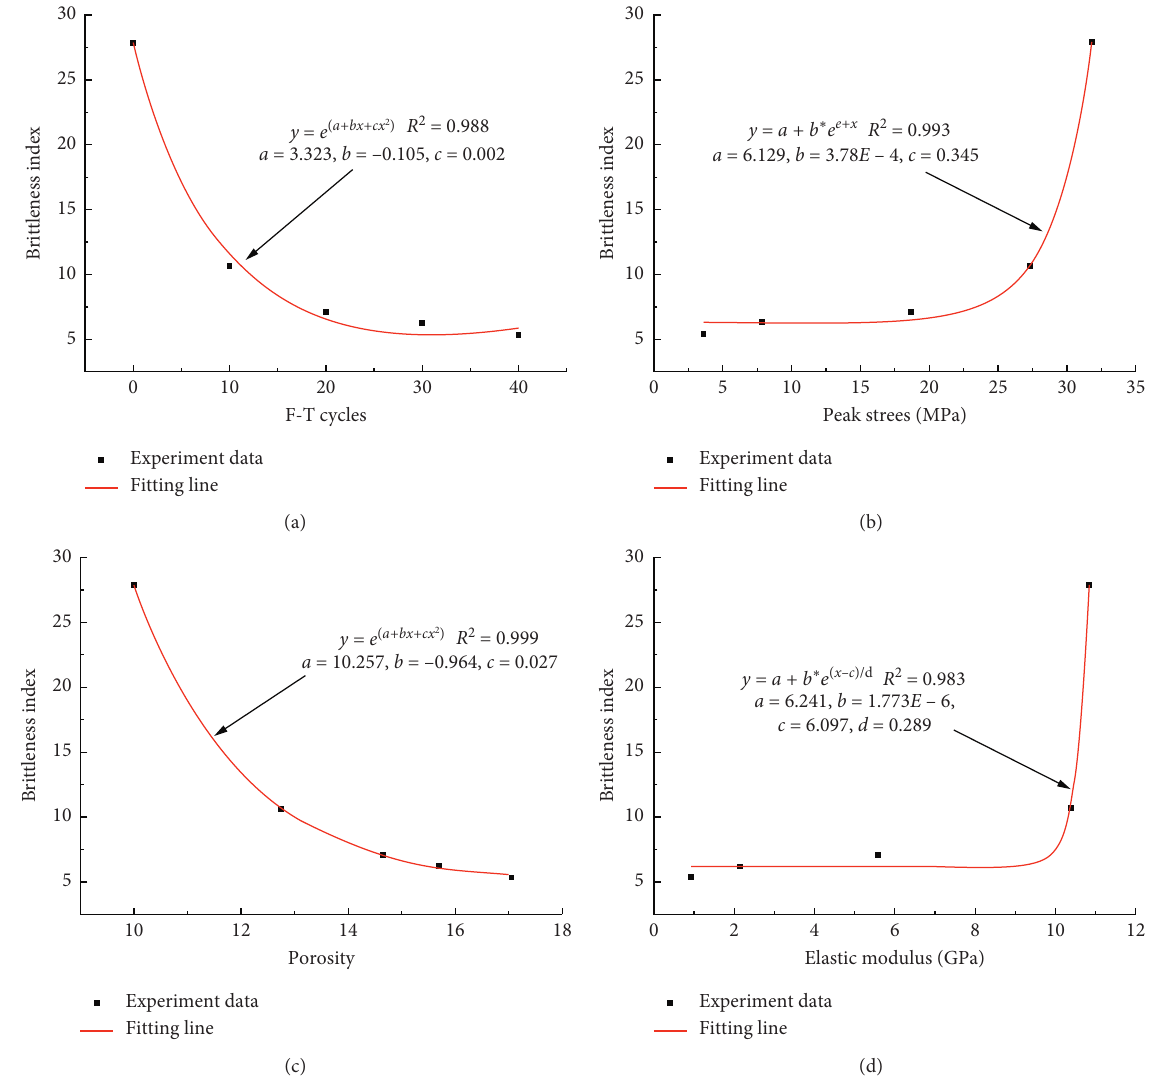
Figure 14: Correlation between the brittleness indices and (a) F-T cycles, (b) peak stress, (c) porosity, and (d) elastic